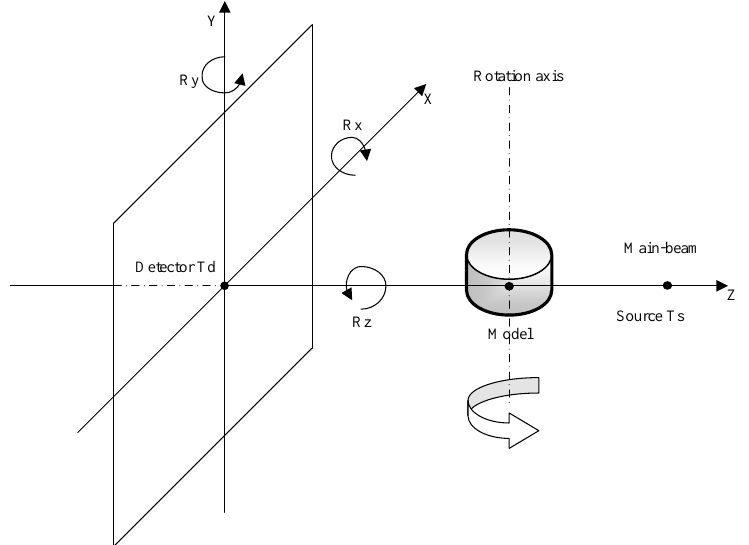
Figure 1. Portable CBCT system geometric